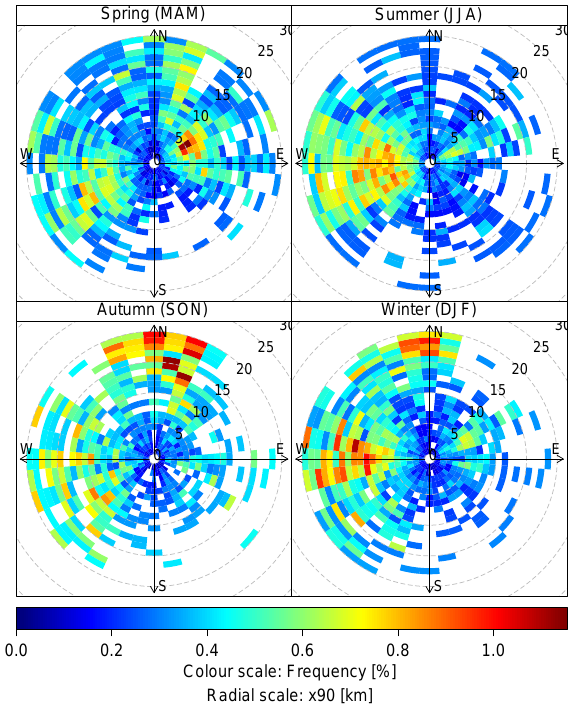
Figure 3. Frequency of occurrence of x 90 (distance from the tower where 90% of the measured fluxes originated from) centred at the BT tower as a function of wind direction and season for the period 15 September 2011–31 December 2014. The flux footprint was esti- mated using an analytical model for non-neutral stratification (Ko- rmann and Meixner, 2001) and the plots were produced using the open-air package for R (Carslaw and Ropkins, 2012, 2016). Bin di- mensions: 10 ◦ (angular scale) × 1km (radial